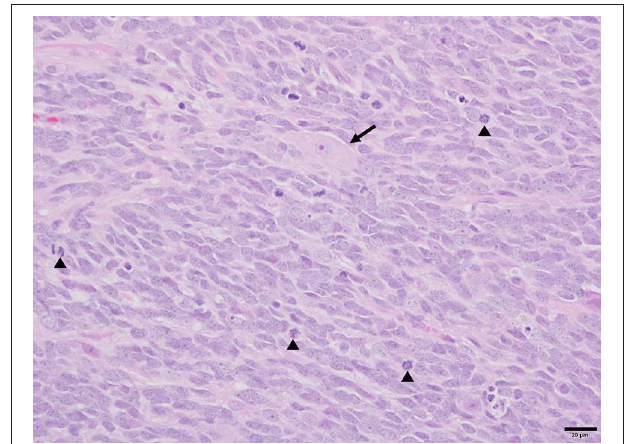
FIGURE 2 | Photomicrograph of medulloblastoma in a dog. Sheets of neoplastic polygonal to elongated cells with large basophilic nuclei and limited pale eosinophilic cytoplasm create the characteristic “small blue tumor” appearance. Further features include a brisk mitotic rate (arrowheads) and rare entrapped cerebellar Purkinje neurons (arrow). H&E. 40 × magnification. Bar = 20